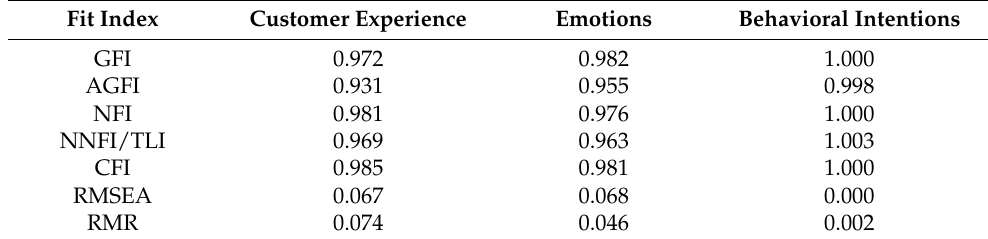
Table 3. Absolute and incremental fit indices of the examined